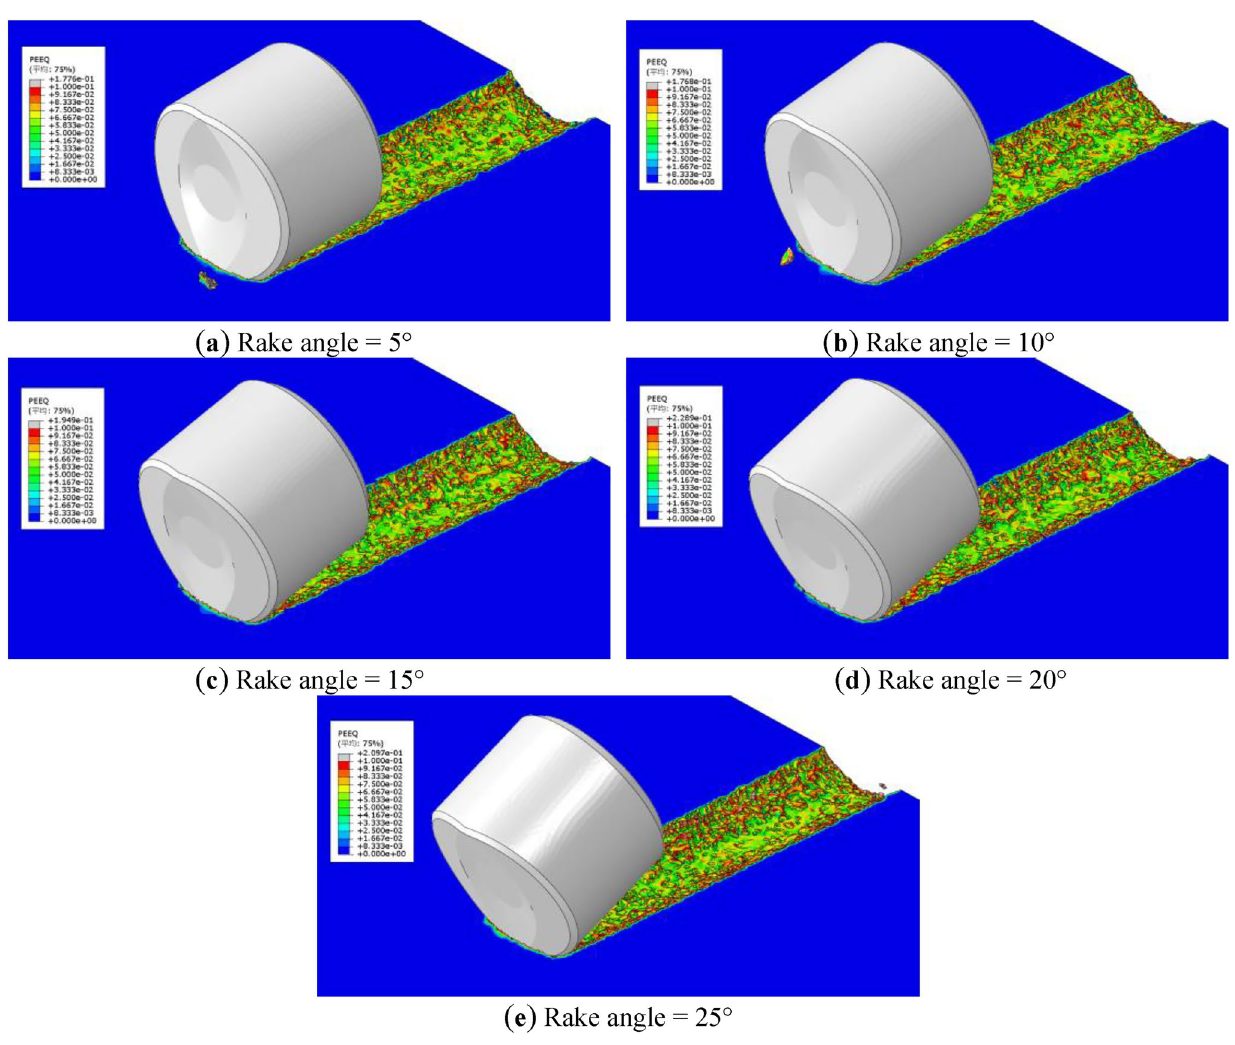
Fig. 19 Equivalent plastic strain generated by different rake angles of the 3D concave-shaped